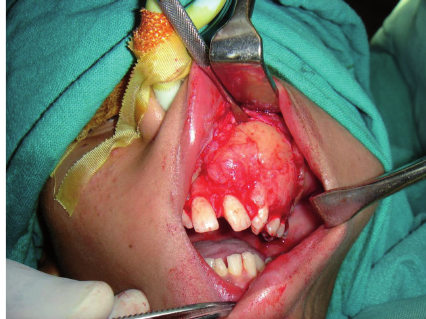
Figure 5: Exposure of the tumour by an intraoral approach.